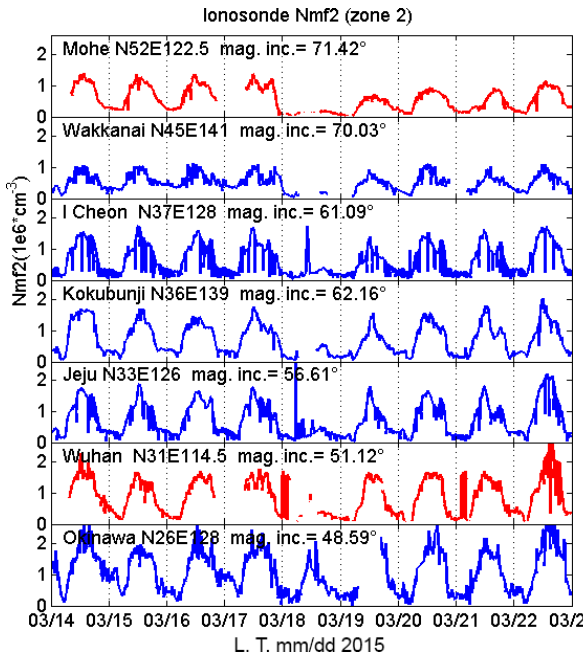
Figure 10. Variations in NmF2 at five SWPC stations and two China Meridian Project ground ionosonde stations in zone 2 during the magnetic storm of March 2015. The blue lines represent the SWPC station, and the red lines denote the China Meridian Project